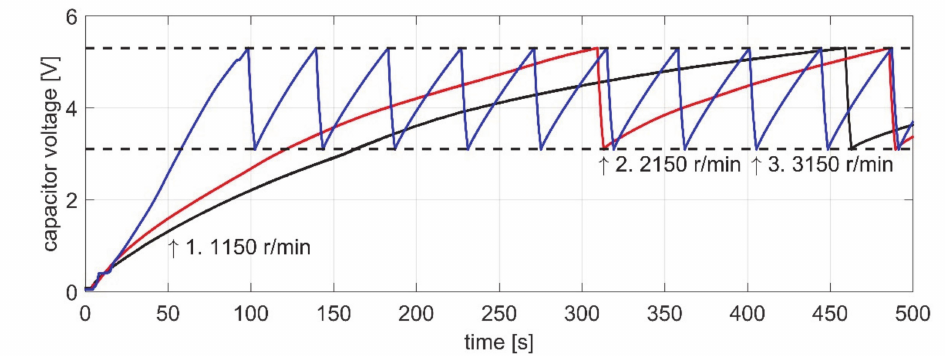
Figure 15. Voltages for three given rotor speeds, d = 16 mm.